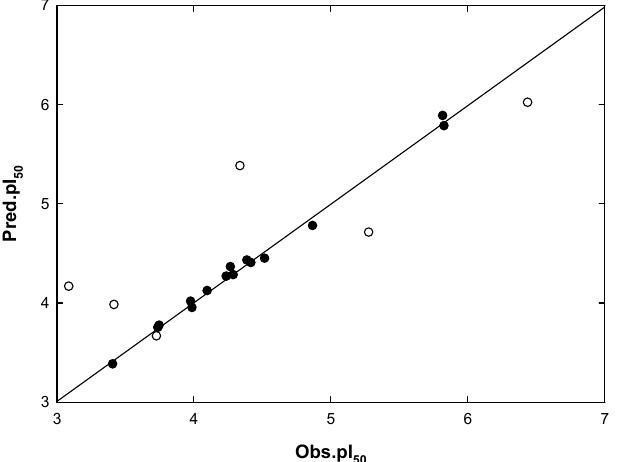
Figure 4. Plot of observed activities ( Obs .pI the COMSIA model IC; ( ● ) training set; ( ○ ) test